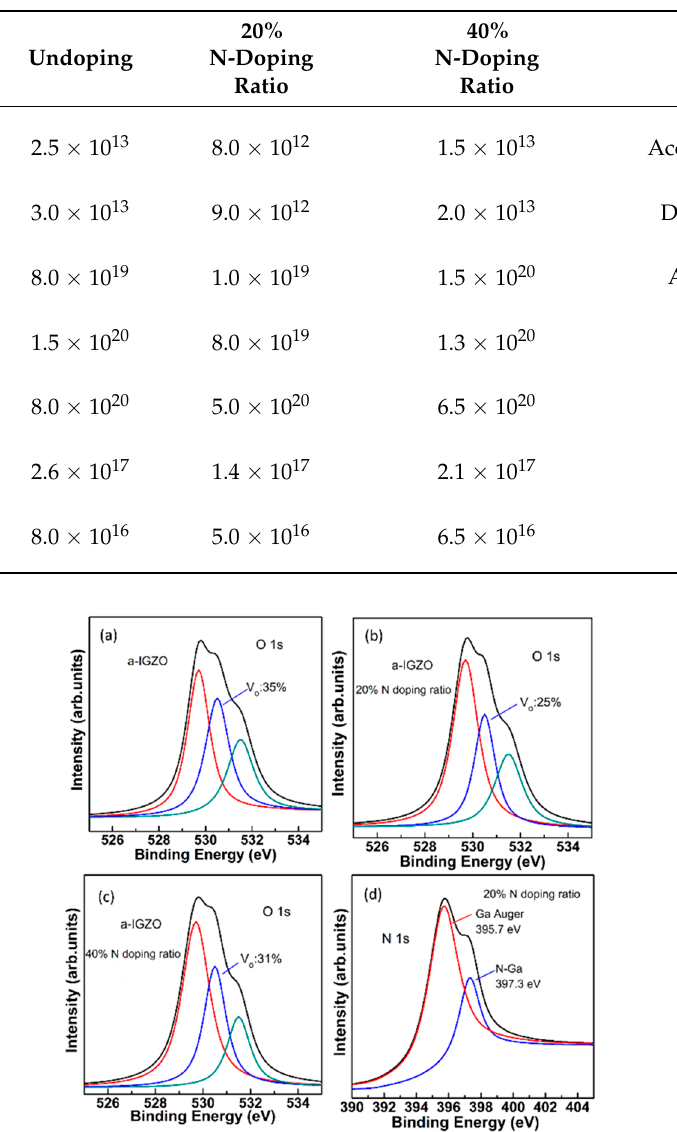
Table 1. Densities of key defect model parameters for a-IGZO TFT fitted after different N-doping ratios.